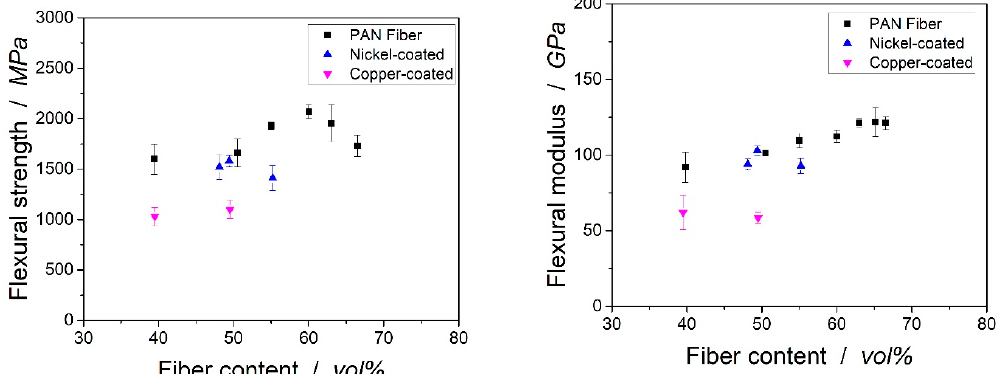
Figure 10. Flexural strength ( left ) and modulus ( right ) of uncoated and metal-coated laminates.